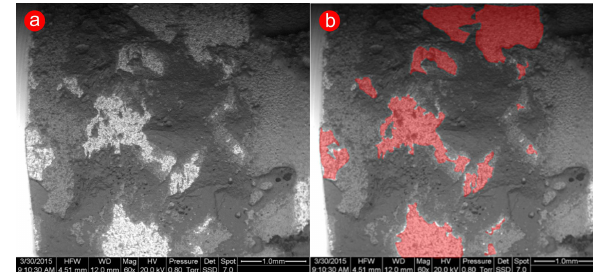
Figure 5: Fracture surface of a sample obtained with the DF precious alloy (a) before and (b) after visible metal area quantification